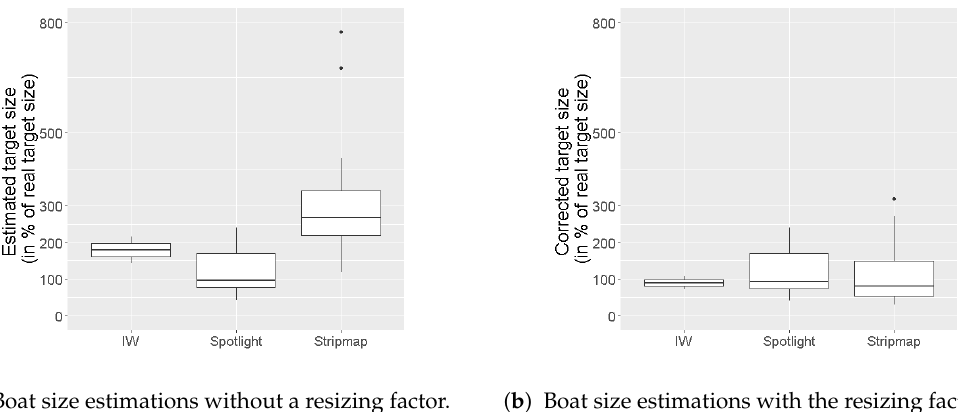
Figure 14. Introducing a resizing factor ( k ) to improve the estimation of the boat